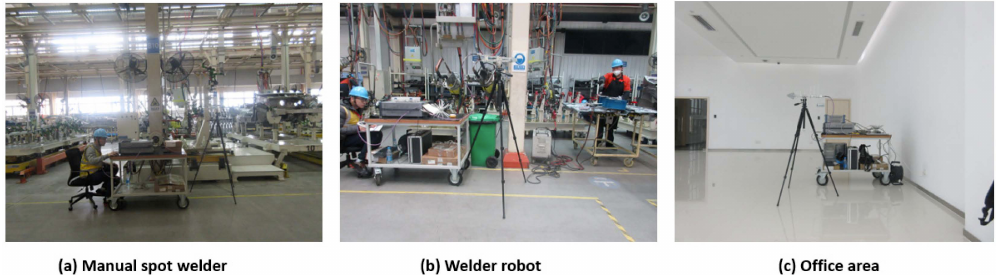
Figure 1. Real scenes of the three positions. ( a ) Manual spot welder; ( b ) Welder robot; ( c ) O ffi ce area.